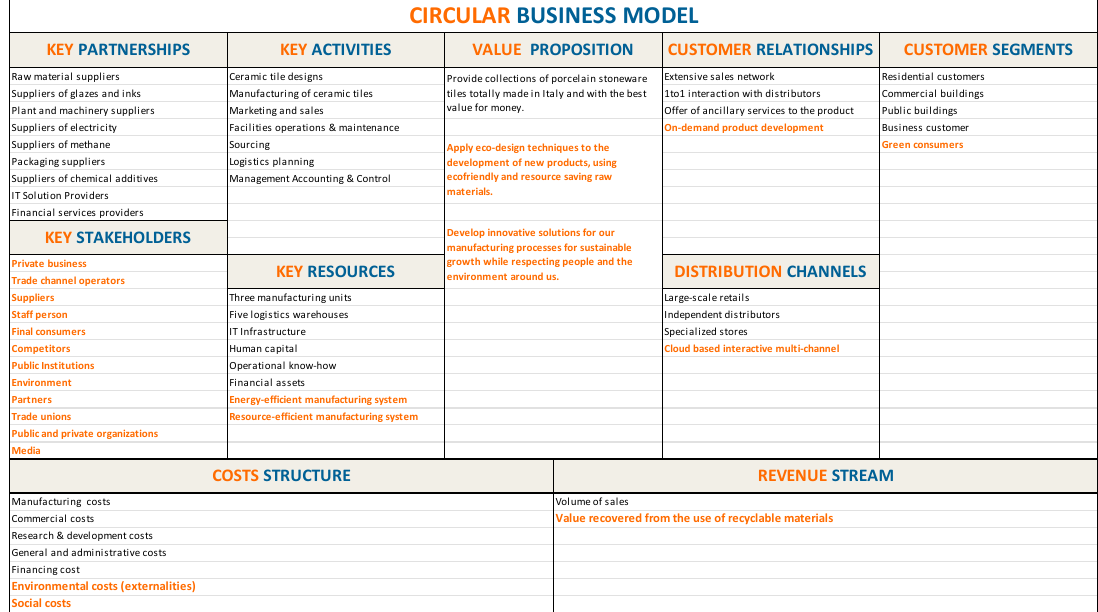
Figure 9. Representation of the new Circular Business Model inspired by Business Model Canvas.